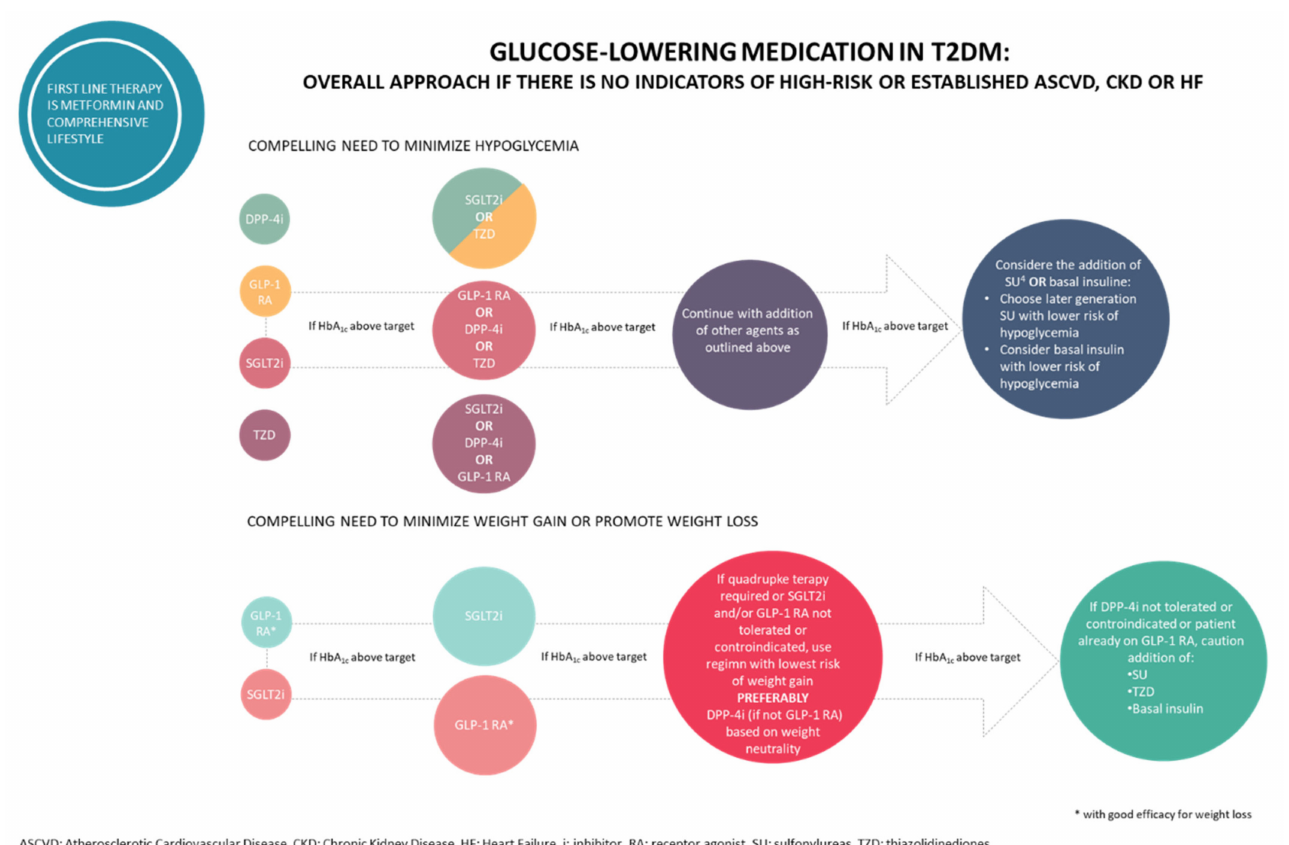
Figure 2. Glucose-lowering medication in